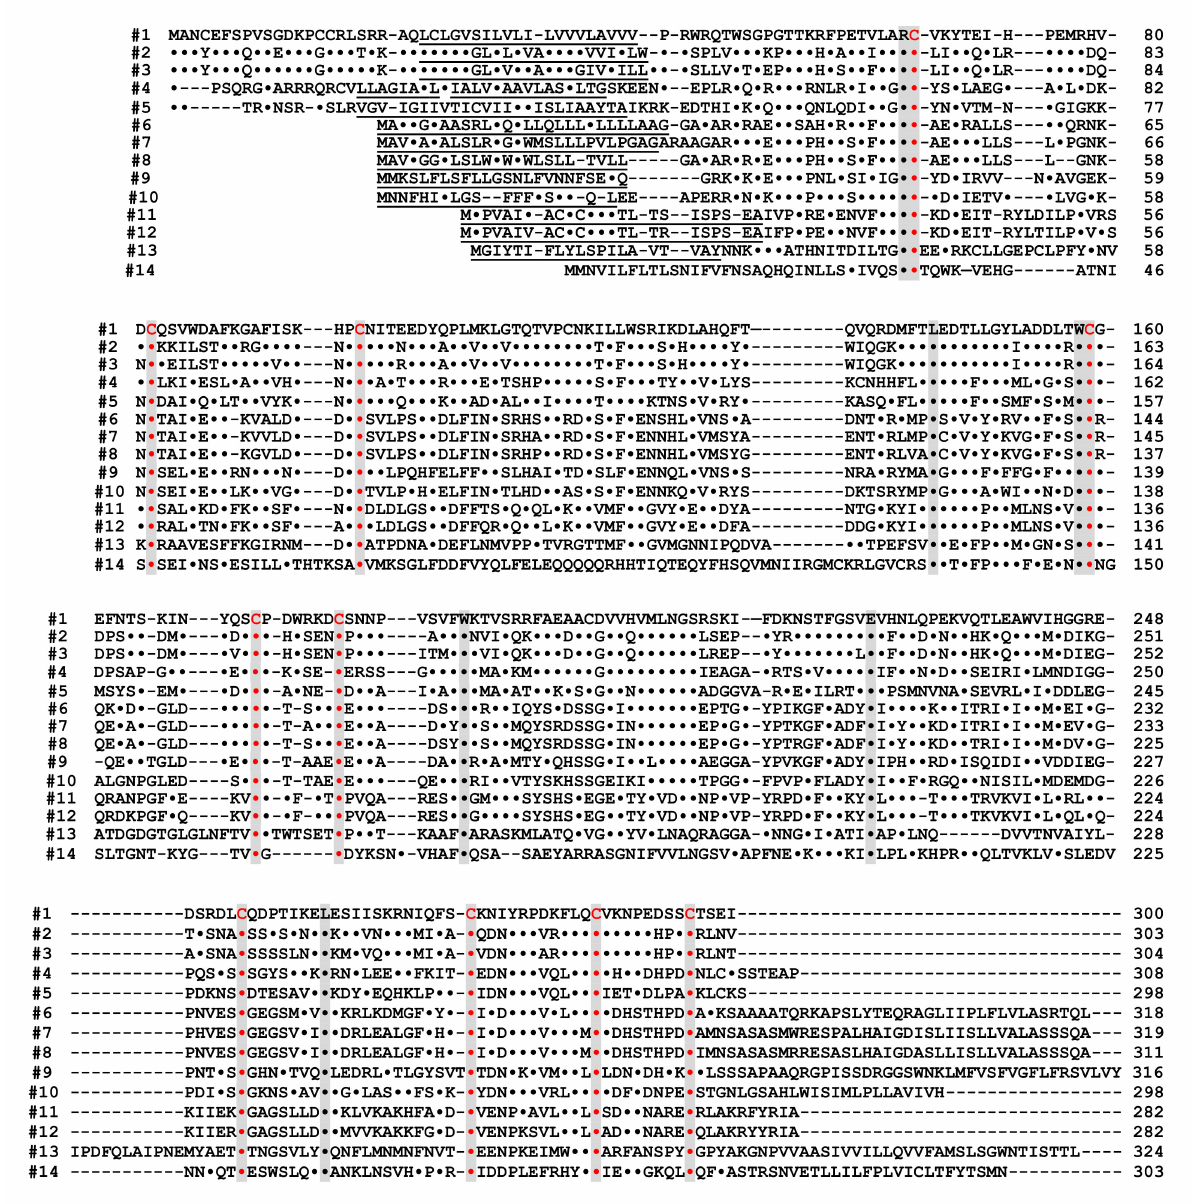
Figure 4. Alignment of the amino acid sequences of the CD38/CD157/ADP-ribosyl cyclase family based on the primary structures of the encoded proteins (adapted from [44]). Dots indicate amino acids identical to human CD38. Dashes indicate gaps for maximal alignment. Ten cysteine and five amino acid residues conserved among all the proteins are highlighted in red and gray,